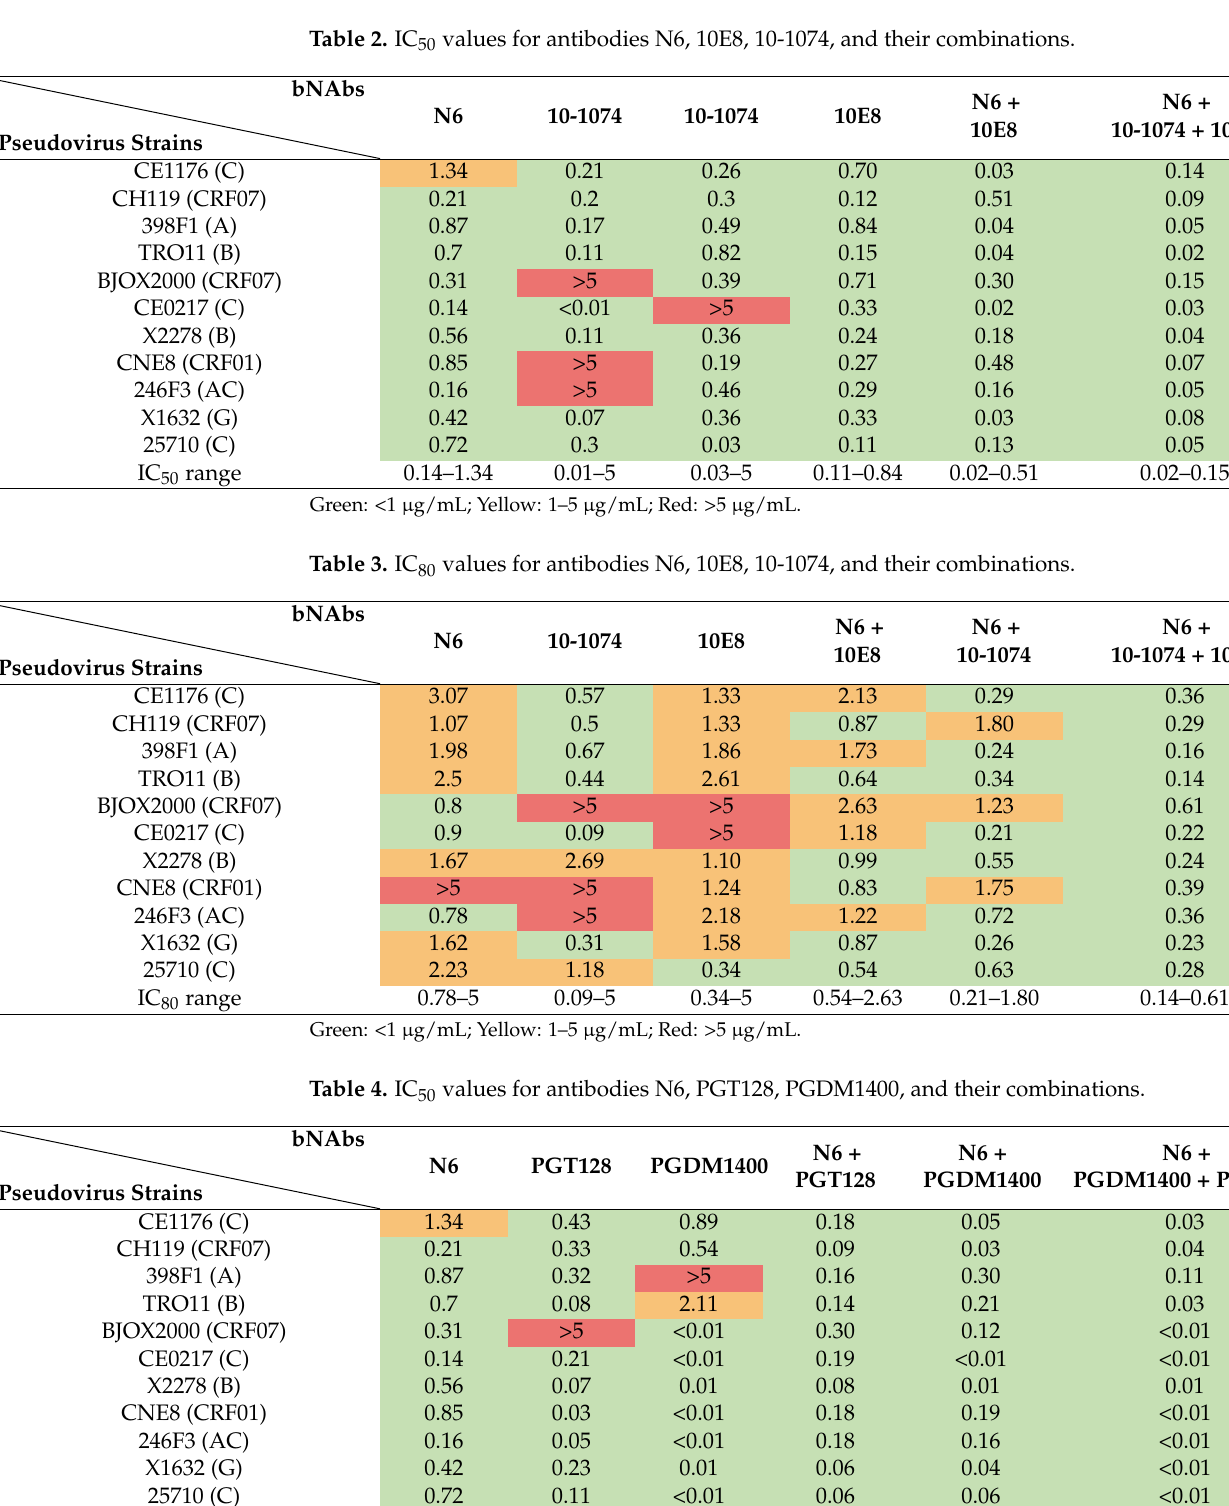
Table 2. IC 50 values for antibodies N6, 10E8, 10-1074, and their combinations.